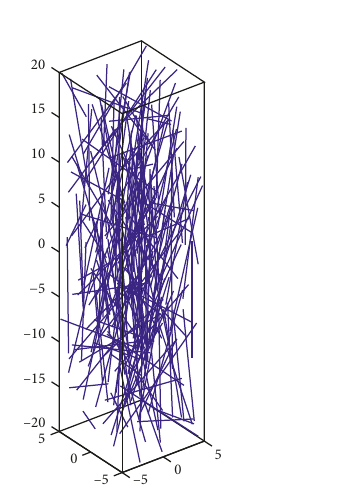
Figure 3: Fiber distribution in the UHPFRC prism.